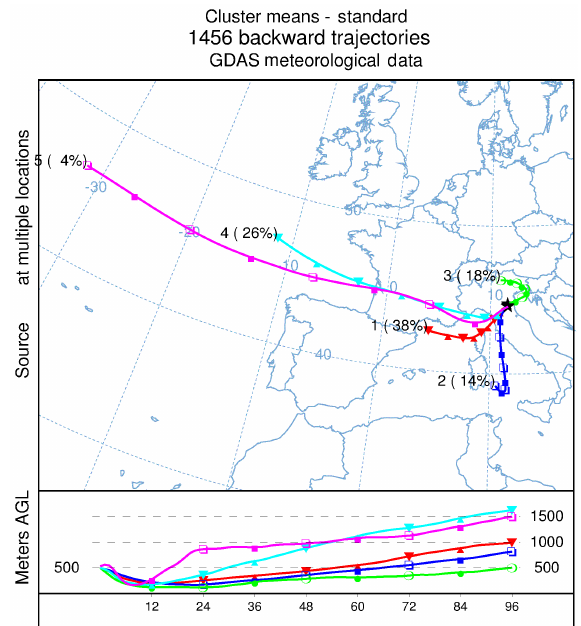
Figure 2. Map with average trajectories for each obtained clus- ter with, in brackets, corresponding percentage of occurrence. The numbers outside the brackets identify each cluster. Figure refers to 96h trajectories arriving at